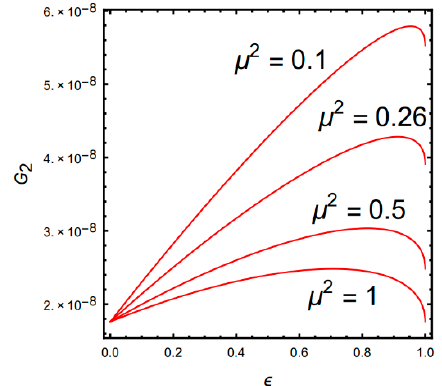
Figure 2. Relationship of gain G 2 and parameter (cid:101)